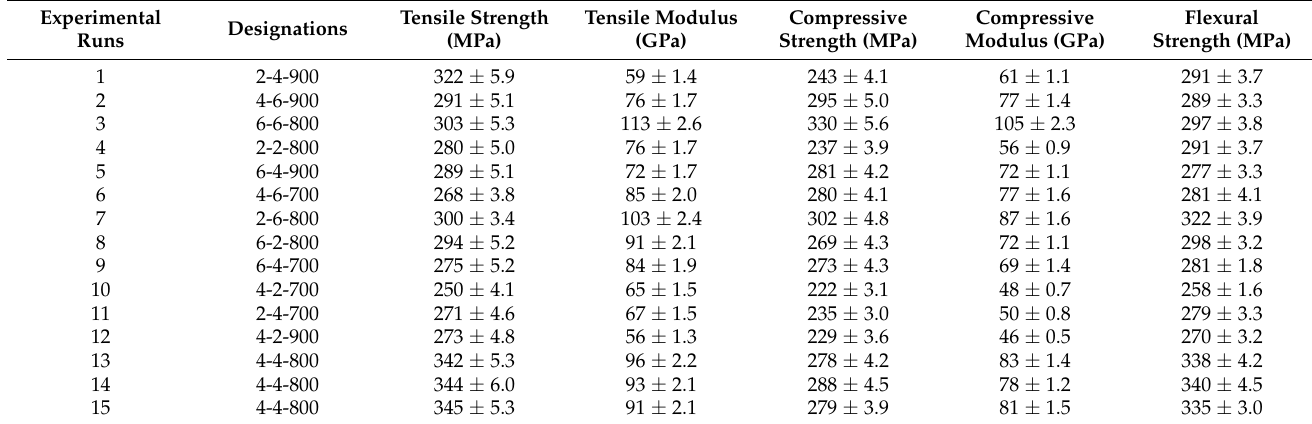
Table 6. Corresponding responses for the experimental